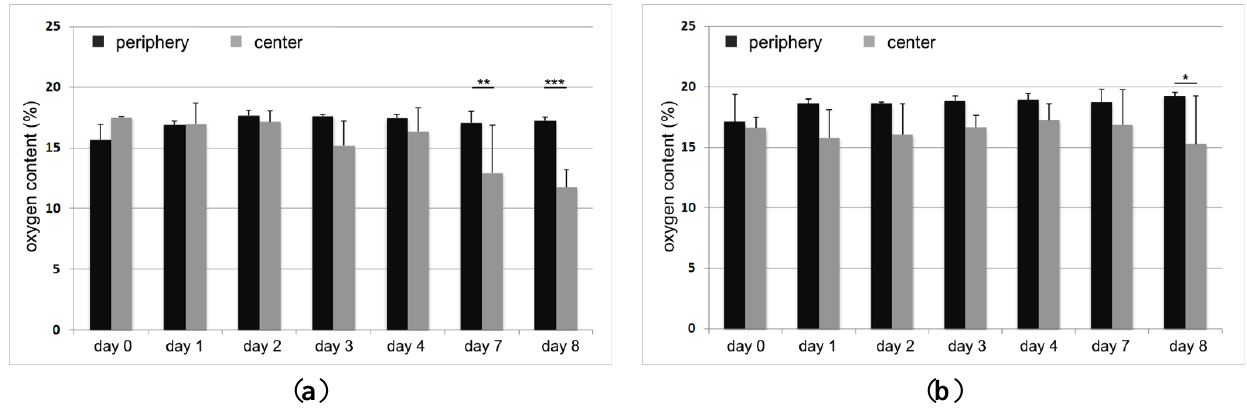
Figure 3. Oxygen concentration in a static 3D culture of human osteoblasts ( n = 3). The measurements were performed in the center and on the periphery of EBM (left) and LBM (right) titanium scaffolds. The mean values ± standard deviations are presented. The statistical analysis was performed using an ONEWAY ANOVA (post-hoc LSD). The statistical significance is based on the oxygen concentration as determined by